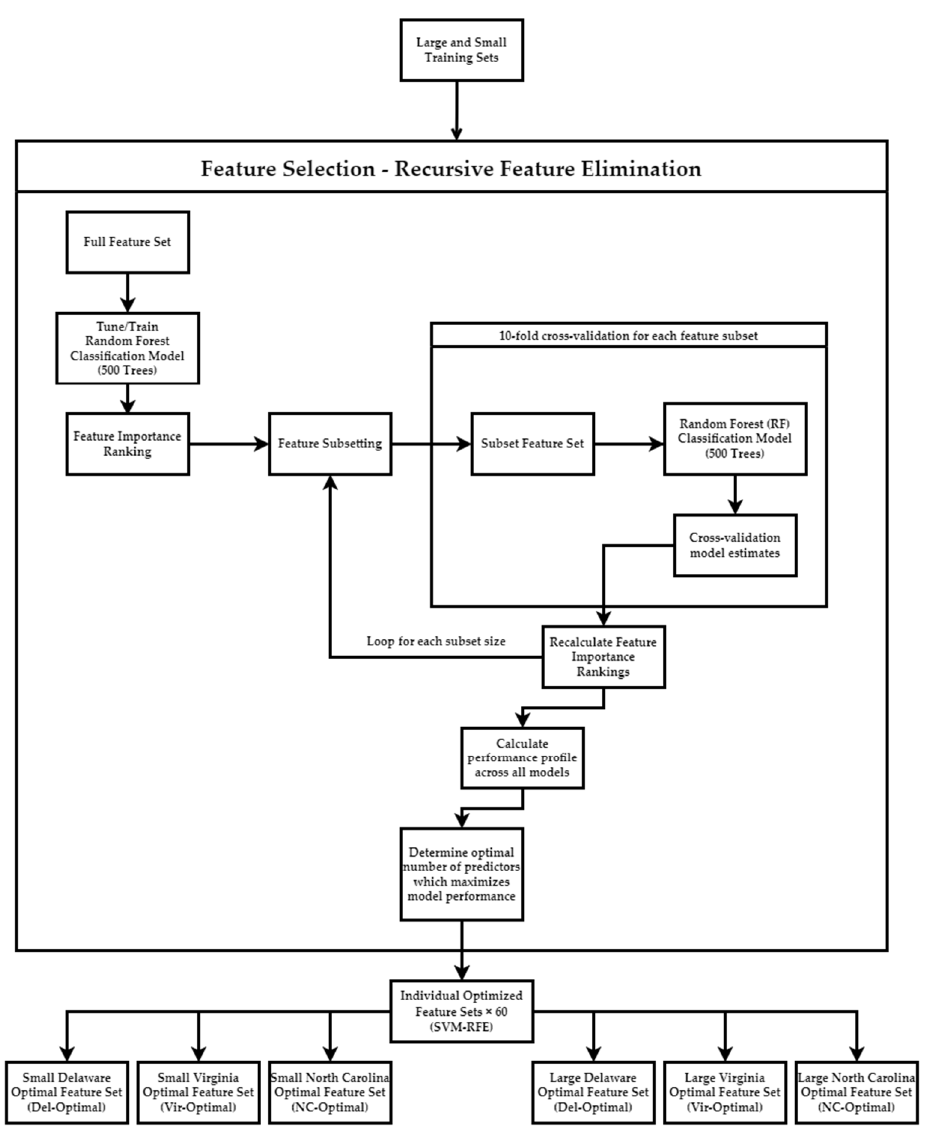
Figure 3. Recursive feature elimination process workflow.